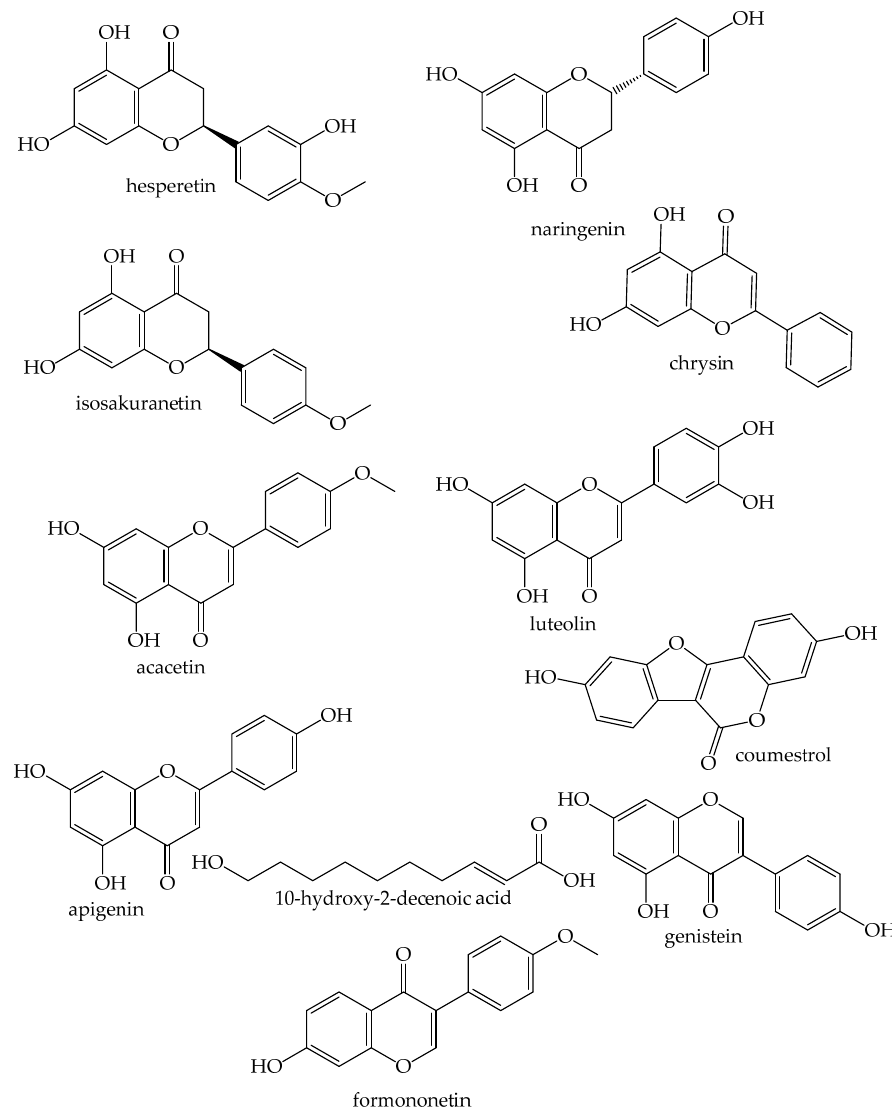
Figure 1. Identified anticancer compounds from royal jelly.